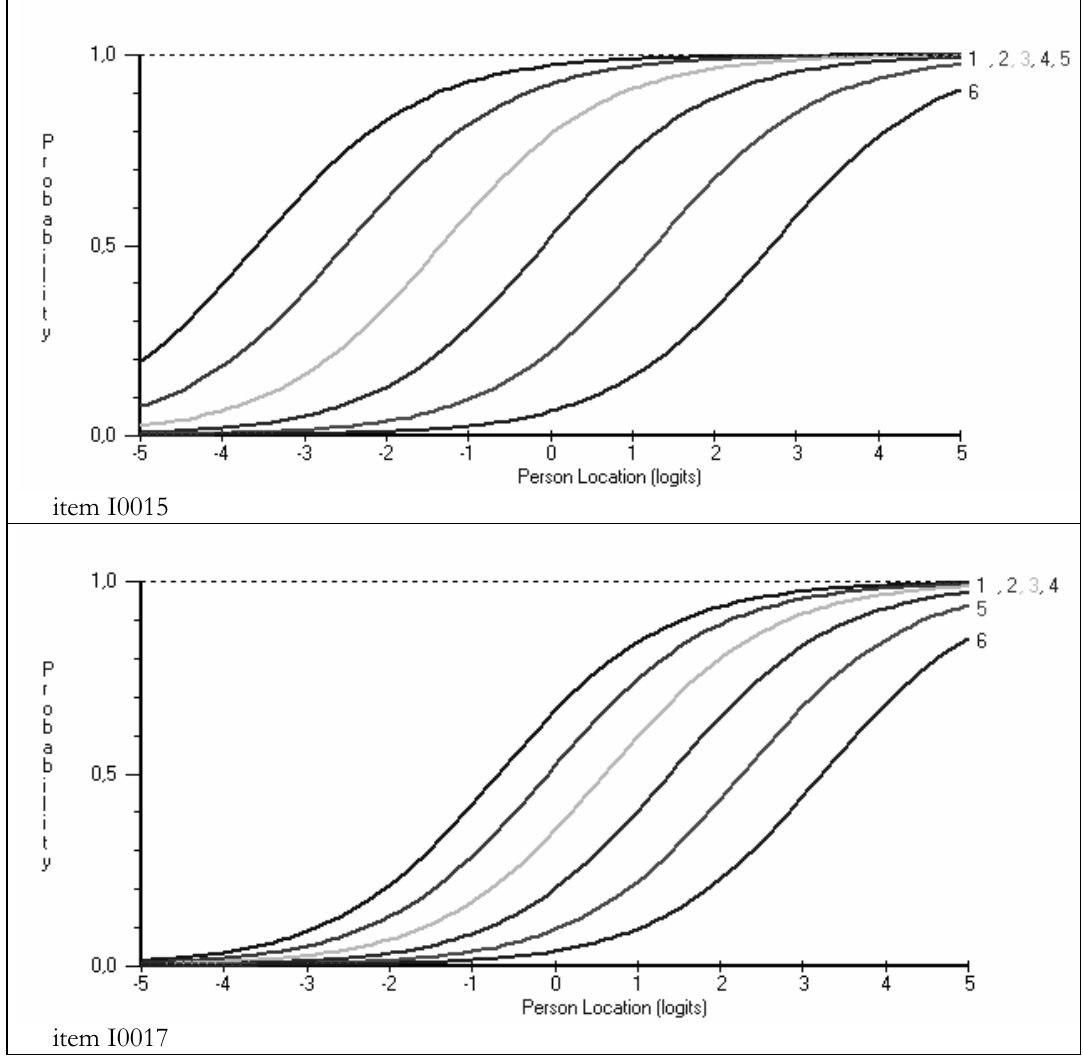
Figura 5 – Threshold Probability Curves (TPC) per gli item I0015 e